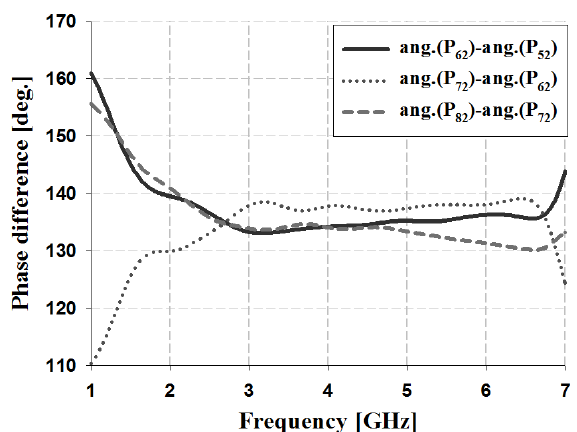
Figure 14. Simulation analysis of phase for input Port 2.